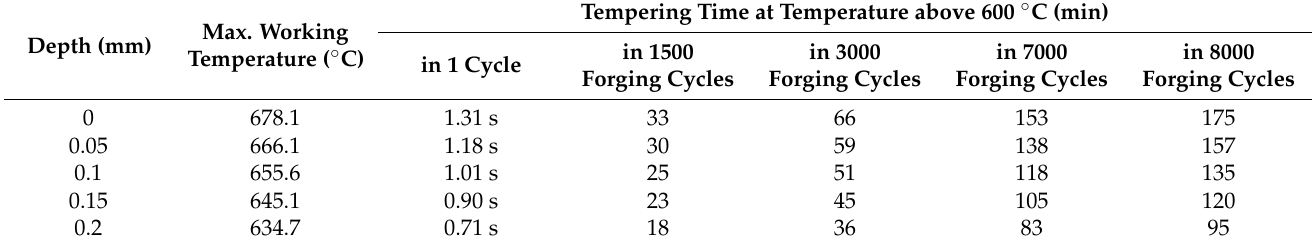
Table 1. Working conditions of the forging die at different depths.